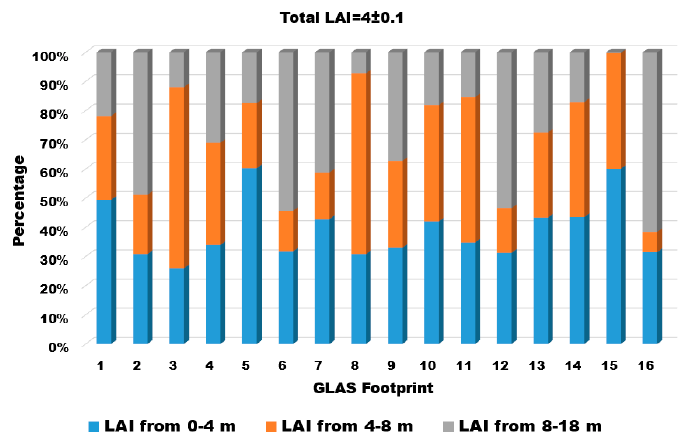
Figure 14. The contribution ratio of different height level LAI (i.e., LAI integration from 0–4 m, 4–8 m, 8–18 m) to the total LAI (LAI = 4 ± 0.1).